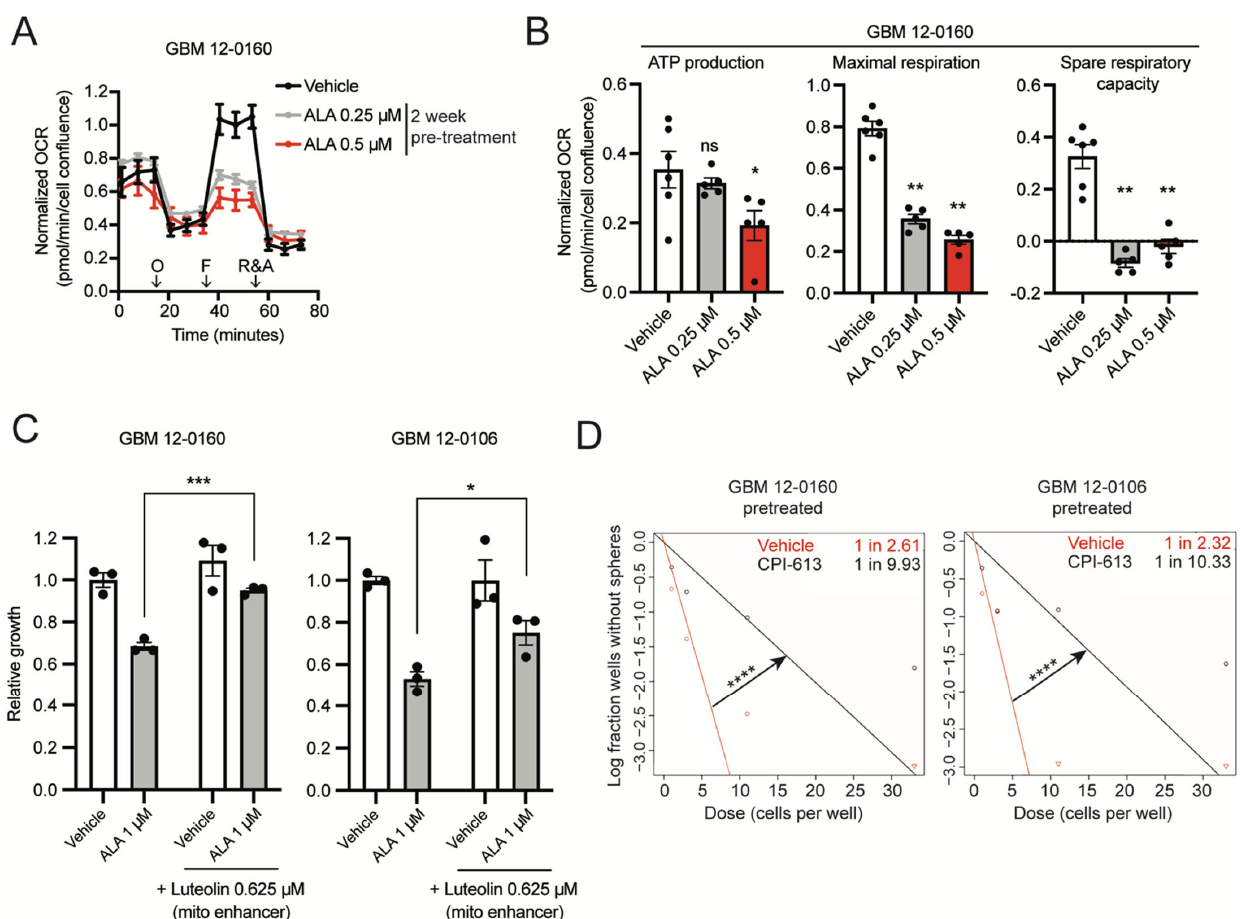
Figure 3. Inhibition of de novo purine synthesis using L ‐ Alanosine (ALA) reduces glioblastoma (GBM) cells’ mitochondrial respiration and eliminates spare respiratory capacity. ( A ) Seahorse XF analysis of GBM 12 ‐ 0160 pretreated for 2 weeks with ALA 0.25 μ M or 0.5 μ M shows ALA reduces maximal respiration. n = 6 replicates for Vehicle, n = 5 replicates for each other condition. O: Oligo ‐ mycin, F: FCCP, R&A: Rotenone and Antimycin A. ( B ) Two ‐ week pretreatment with ALA reduces ATP production, maximal respiration, and spare respiratory capacity in GBM 12 ‐ 0160. n = 6 repli ‐ cates for Vehicle, n = 5 replicates for each other condition. ( C ) Luteolin (mitochondria respiration enhancer) treatment at 0.625 μ M partially rescues ALA ‐ induced proliferation inhibition. Growth assayed with Incucyte Live Cell Imaging system, 5 days (percentage confluence). Growth shown relative to Vehicle condition, n = 3 replicates for each condition. ( D ) Extreme limiting dilution assays (ELDAs) show 2 ‐ week pretreatment with CPI ‐ 613 100 μ M decreases stem cell frequency in GBM cells. Stem cell frequency (1 in n ) for each condition shown on plot. 33, 11, 3, 1 cells seeded per well, n = 10 replicates per condition. Data shown are mean +/ − SEM. Data analyzed using Mann ‐ Whitney test ( B ), Welch’s t ‐ test ( C ), ELDA Chi ‐ square test ( D ); ns: not significant, * p < 0.05, ** p < 0.01, *** p < 0.001, **** p < 0.0001.